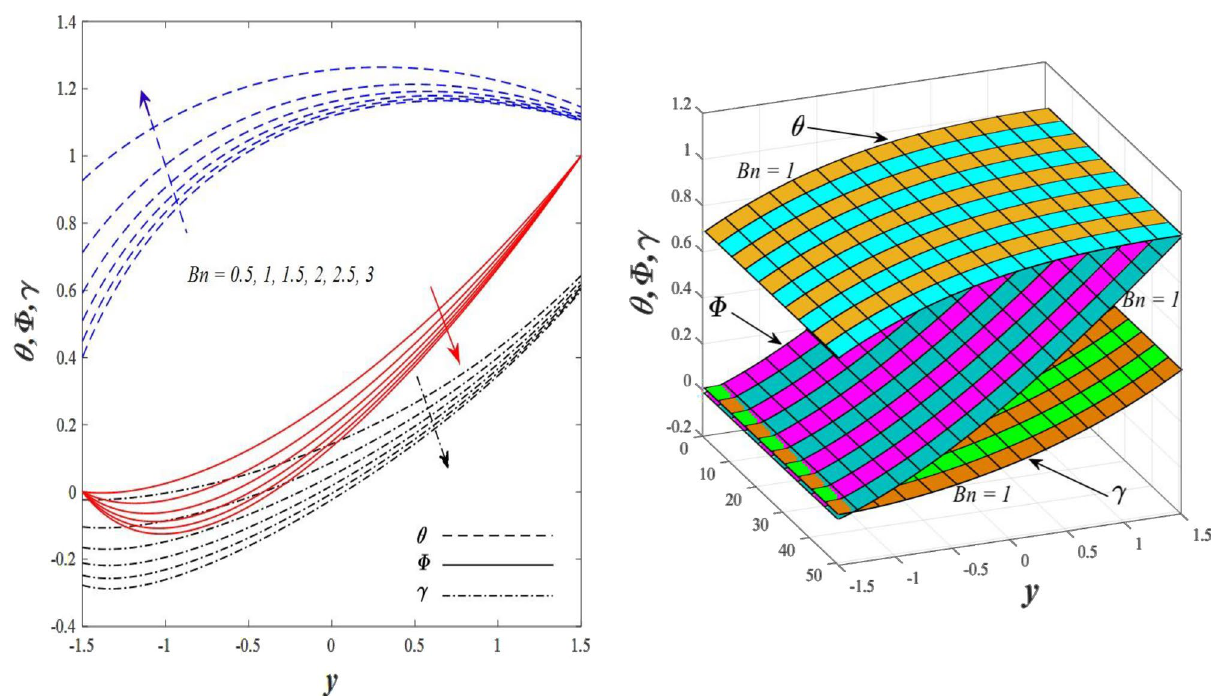
Figure 17. Effect of Brinkman number Bn on the distributions of both temperature, solutal concentration and nanoparticles volume